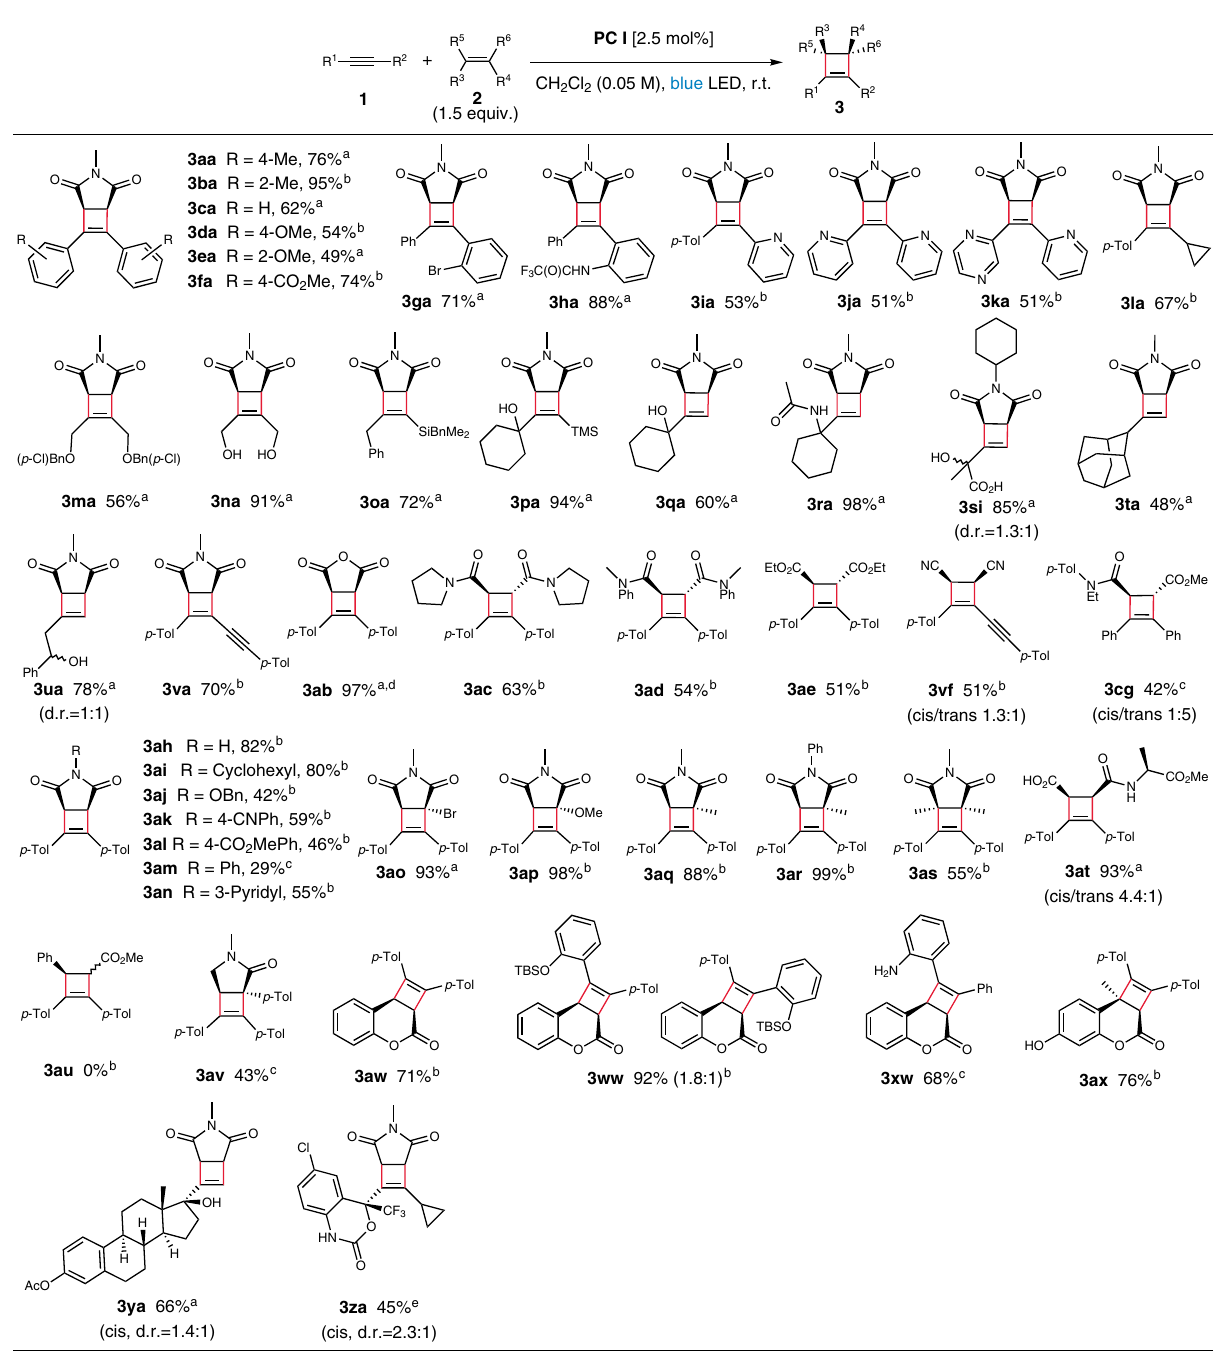
Fig. 2 Scope of the intermolecular reaction. Unless noted otherwise, all reactions were conducted with 0.1 mmol scale under irradiation of 12 W blue LED strip and Ar atmosphere; Isolated yields; Racemates for all cyclobutenes. a Reaction time: 1 – 18 h. b Reaction time: 24 – 48 h. c Reaction time: 53 h – 3d. d Isolated as N -benzylamide by in-situ treatment with benzylamine after completion of the cycloaddition; Two-step yield. e Reaction time: 5d; the reaction was conducted with 15 equiv. of alkene and PC III instead of PC I